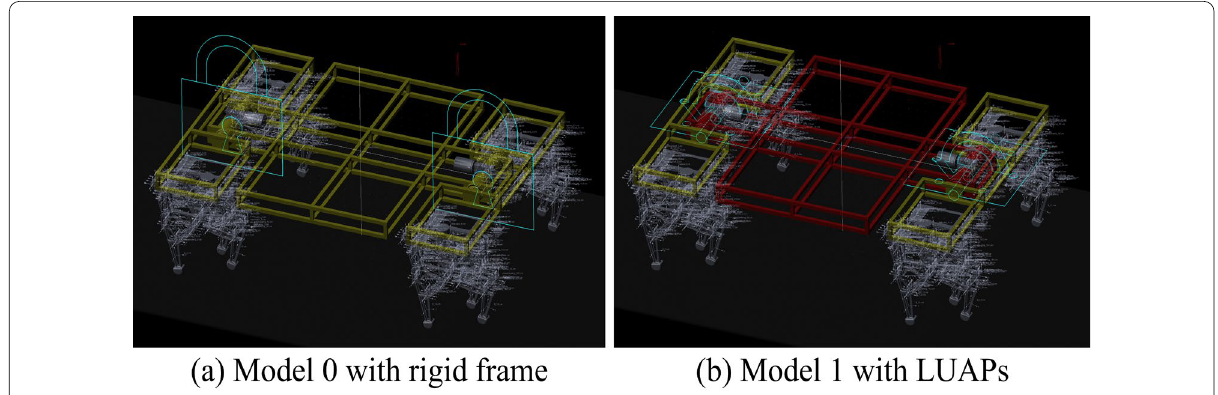
Figure 14 Simulation models